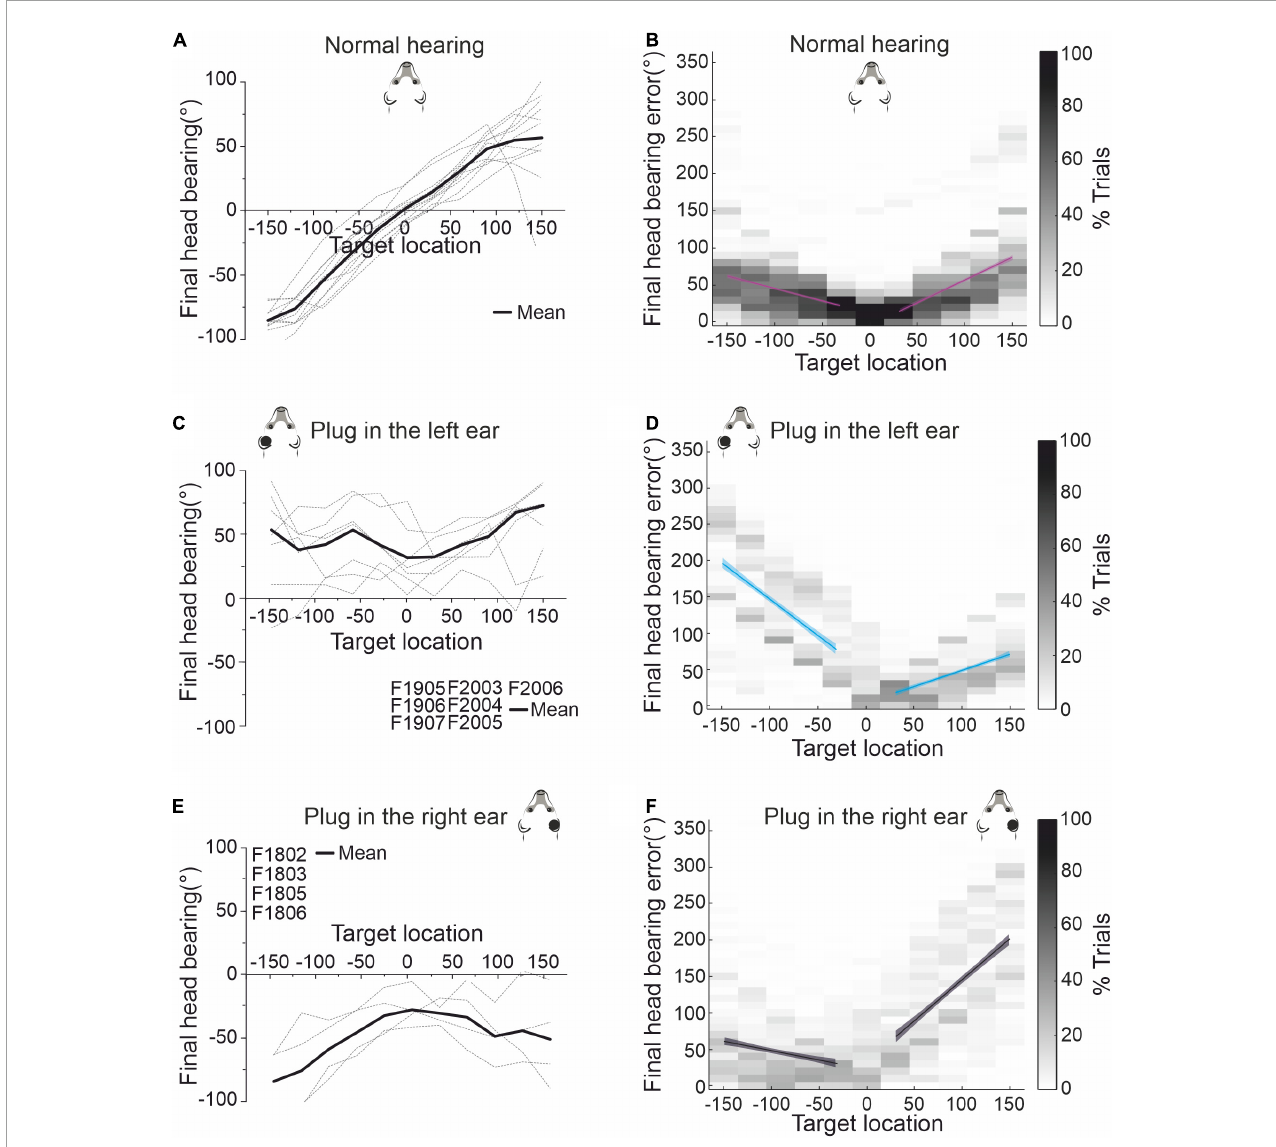
FIGURE3 Effect of plugging either the left or the right ear on the accuracy of sound-evoked head-orienting responses. (A) Average final head bearing versus target location in normal hearing conditions for each of the animals (gray dashed lines) that participated in this study. Positive values correspond to targets on the right and rightward head movements, and negative values to targets on the left and leftward movements. The solid line represents the mean across animals. (B) Mean final head bearing errors versus target location in normal binaural hearing conditions for all animals. Linear regressions and their 95% confidence intervals are fitted independently for right and left target locations (magenta lines). (C) Mean final head bearing versus target location in the first 3 days with the left ear occluded. (D) Mean final head bearing errors versus target location in the first 3 days with the left ear occluded. Linear regressions and their 95% confidence intervals are fitted independently for right and left target locations (blue). (E) Mean final head bearing versus target location in the first 3 days with the right ear occluded. (F) Mean final head bearing errors versus target location in the first 3 days with the left ear occluded. Linear regressions and their 95% confidence intervals are fitted independently for right and left target locations (black/gray).